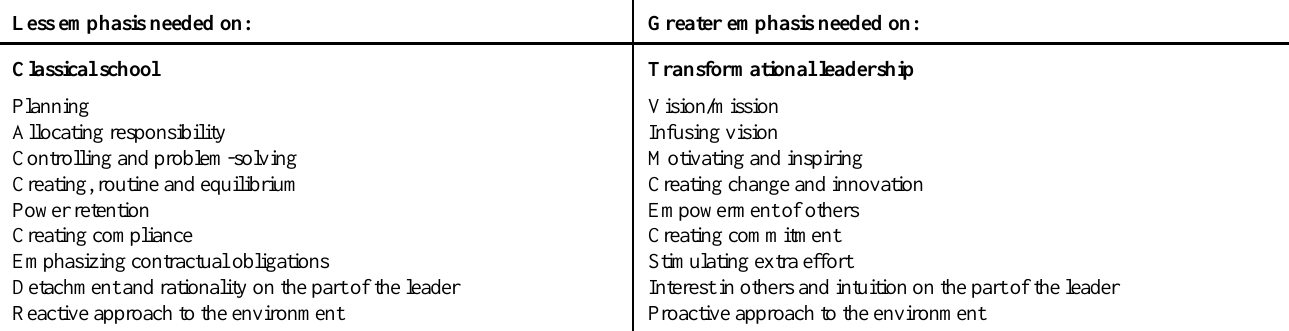
Table 1: Themes of leadership Less emphasis needed on: Greater emphasis needed